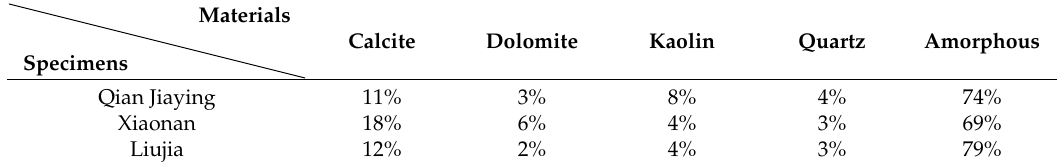
Figure 7. Pulverized coal.